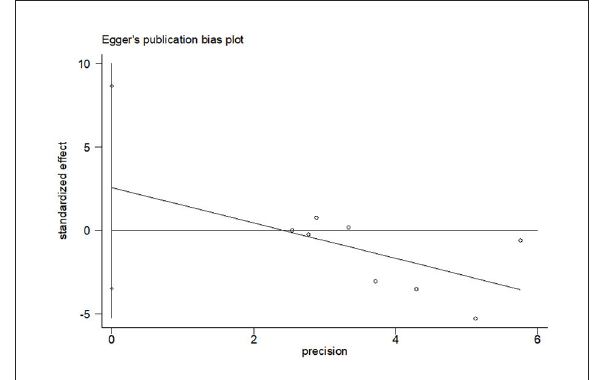
FIGURE12 Publication bias test of CBT effect on